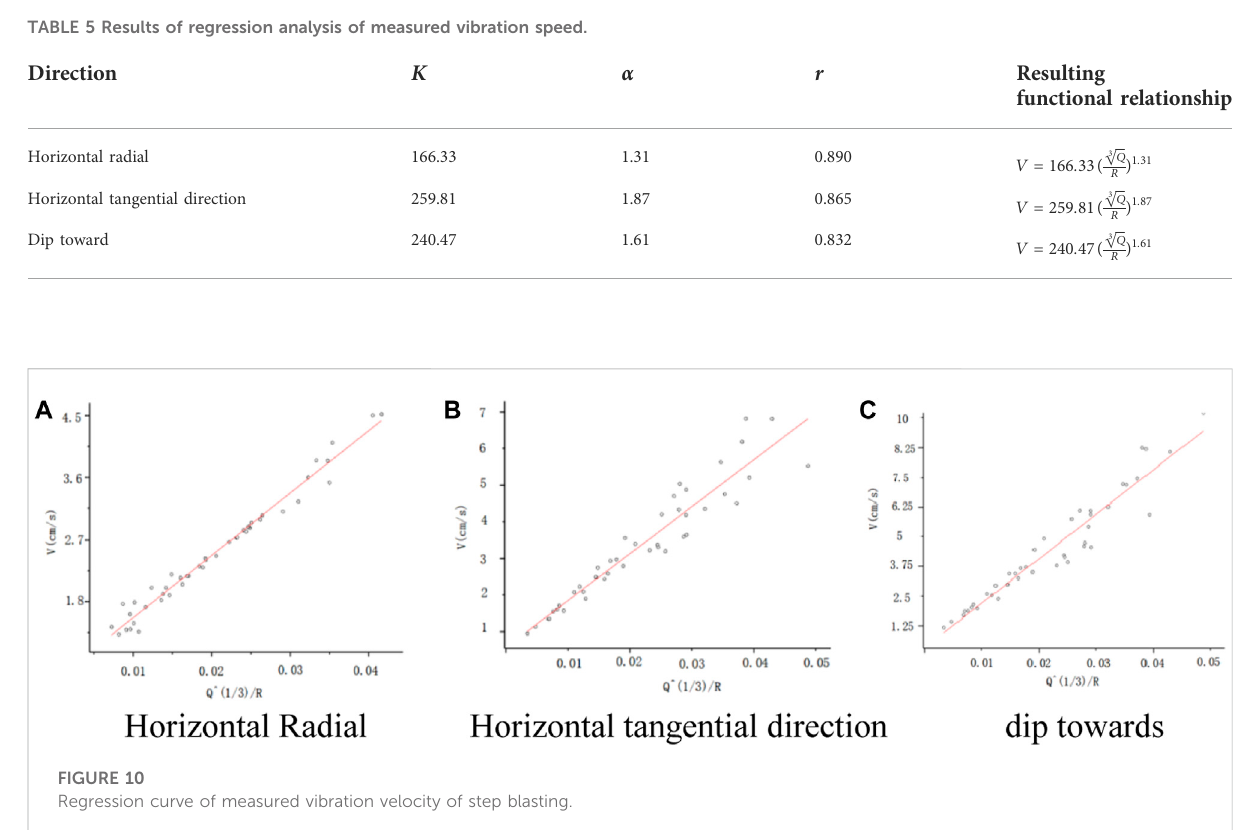
Figure 9. Based on the regression analysis test data of slope vibration of step blasting, the Sadowski regression analysis of measured vibration data was carried out by using the one- dimensional linear regression method through the formula, and the accuracy analysis was carried out by using the regression results. Regression analysis results are shown in Table 4, and the regression curve of measured vibration speed of pre-cracking blasting is shown in Figure 9. Regression analysis